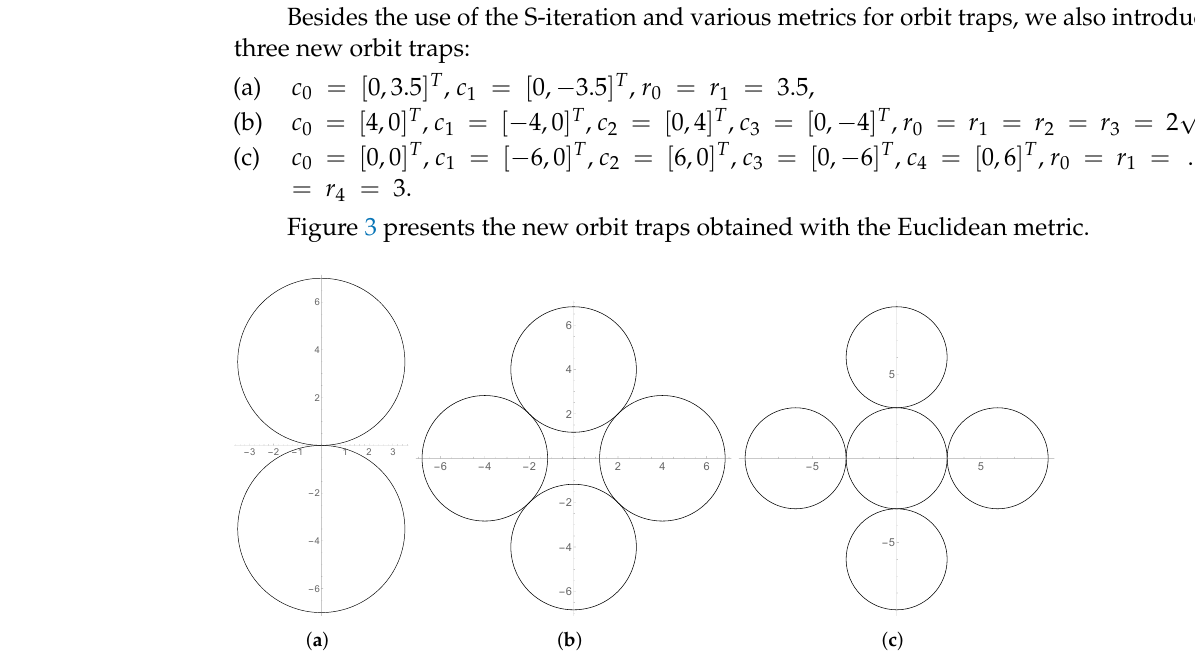
Figure 2. Circles with centre [ 0,0 ] T and radius 1 obtained with various metrics. ( a ) l p ; ( b ) Chebyshev; and ( c ) Rickman.